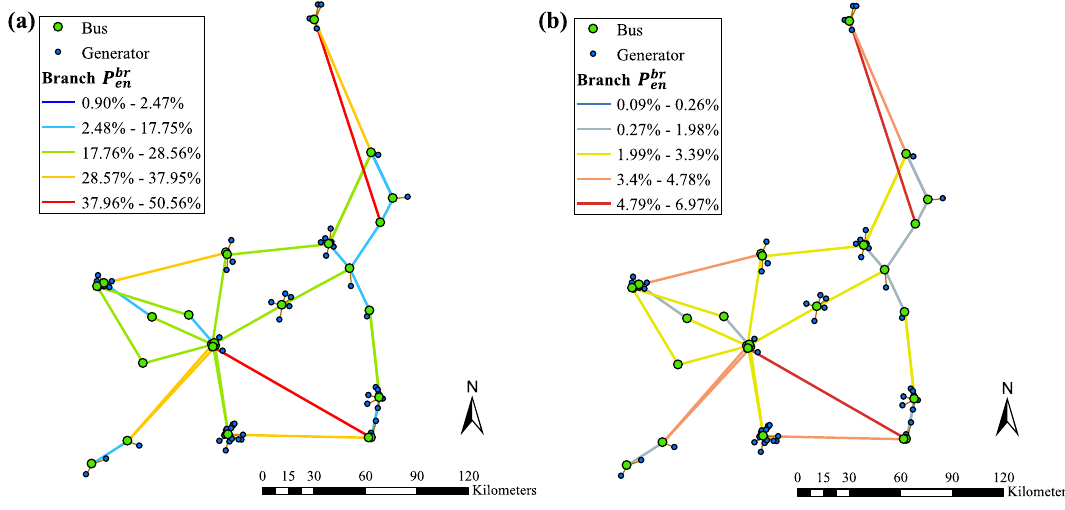
Figure 15. Map of the power transmission system and its probability of encroachment under a 48 h strong wind event: ( a ) Y clr